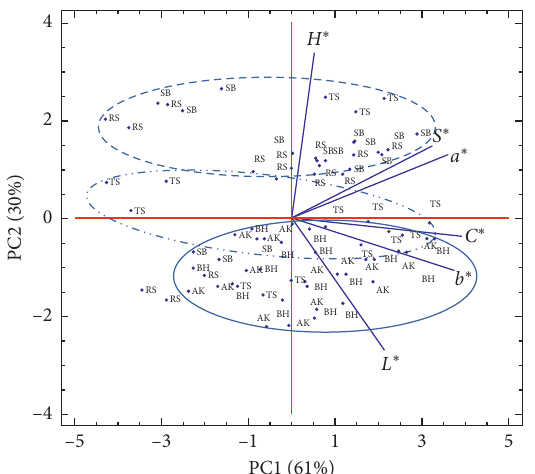
Figure 2: Principal component analysis (PCA) projections on PC1 and PC2. The eigenvalues are symbolized as blue segments rep- resenting traits that most affect each principal component. The 75 points plotted are cultivar mean values of each studied kernel color index: brightness index ( L ∗ ), redness index ( a ∗ ), yellowness index ( b ∗ ), chroma ( C ∗ ), hue angle ( H ∗ ), and metric saturation ( S ∗ ) of five